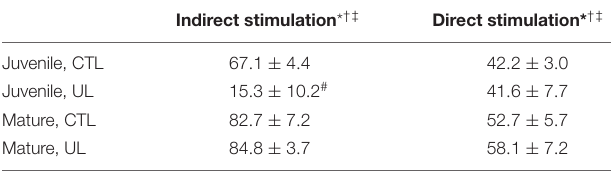
TABLE 5 | Effects of age (mature/juvenile) and treatment (control/unloaded) on fatigue (% decline), during a 5 min train of indirect (nerve) or direct (muscle)